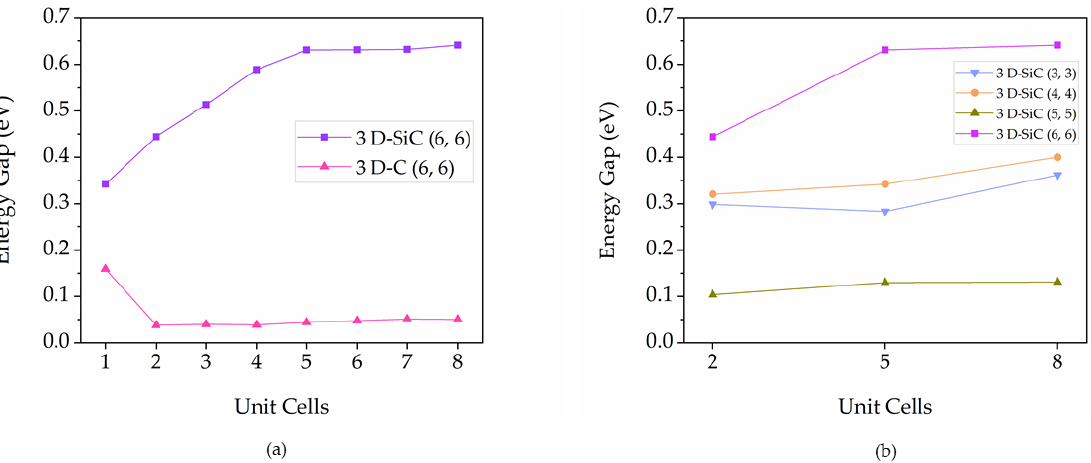
Figure 8. HOMO-LUMO energy gaps of ( a ) 3D pillared C and SiC nanostructures as a function of pillar length and ( b ) 3D pillared SiC nanostructures as a function of pillar diameter.